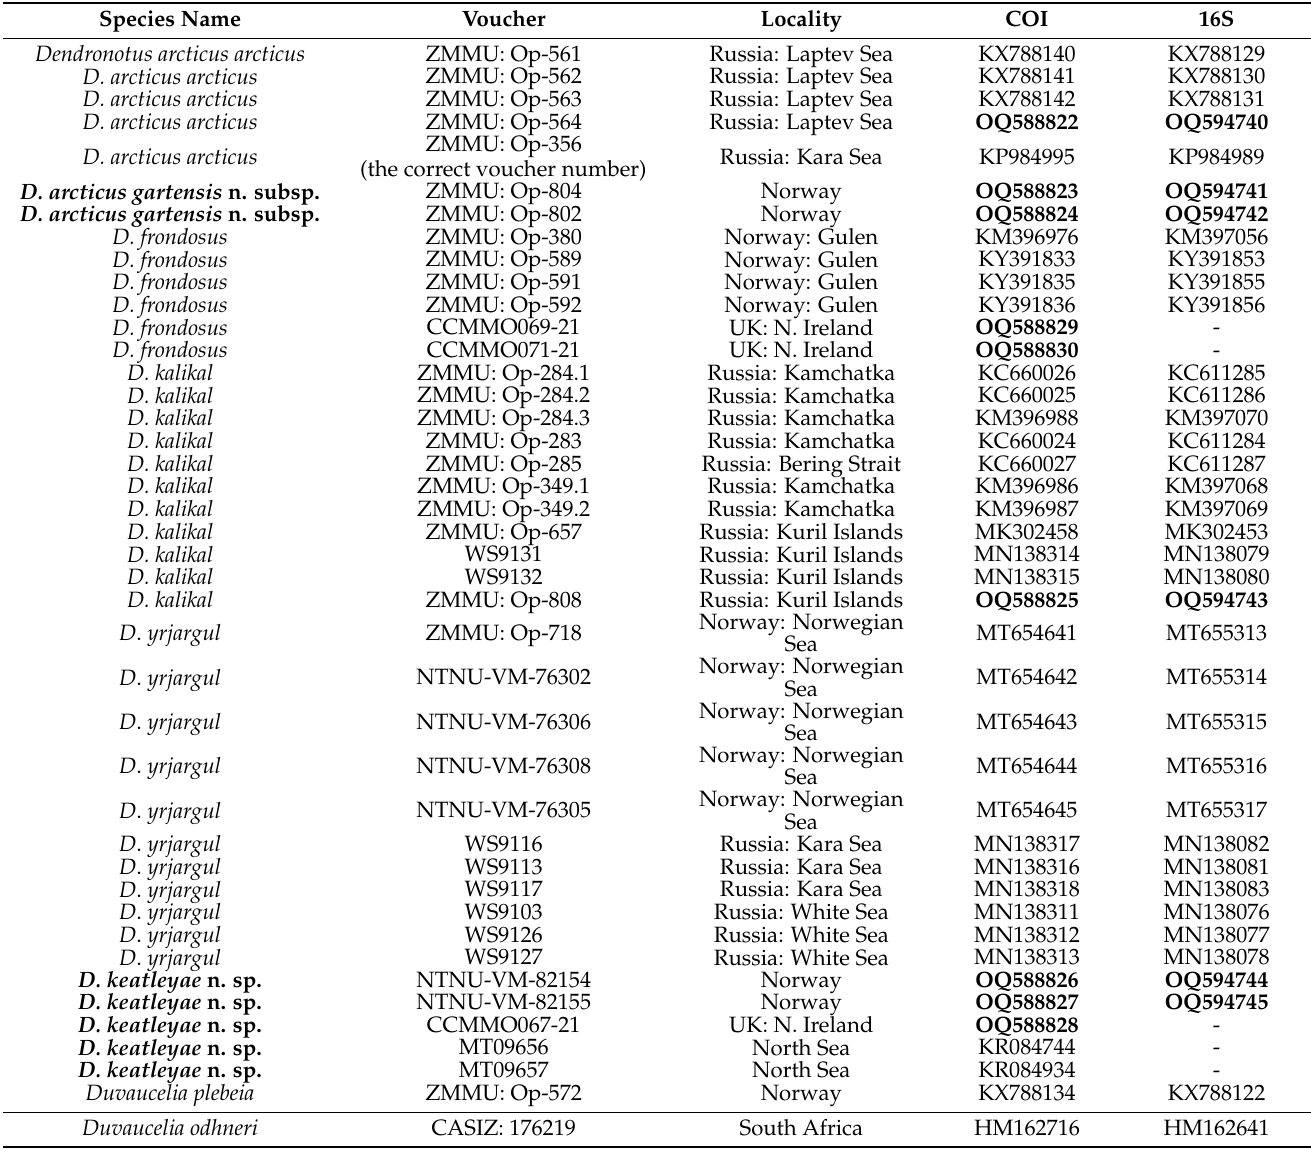
Table 1. List of specimens used for molecular